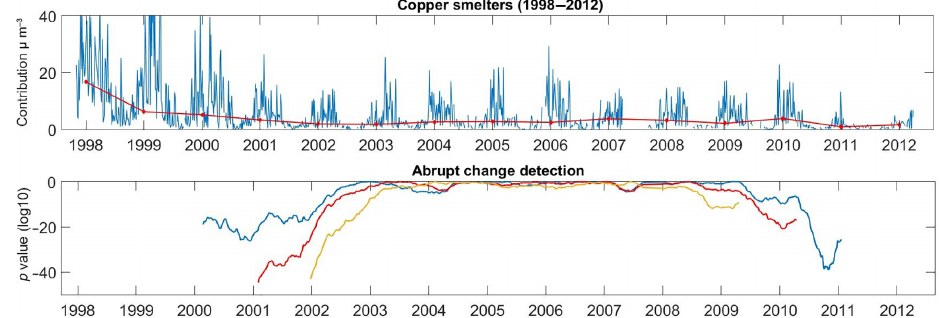
Figure 6. Top panel: time series of copper smelters’ contribution to PM 2 . 5 and the annual median in red. Bottom panel: p value from a Mann–Whitney hypothesis test comparing the median of both halves of a sliding window, repeated for three different window lengths (320, 480 and 640 days for blue, red and yellow,